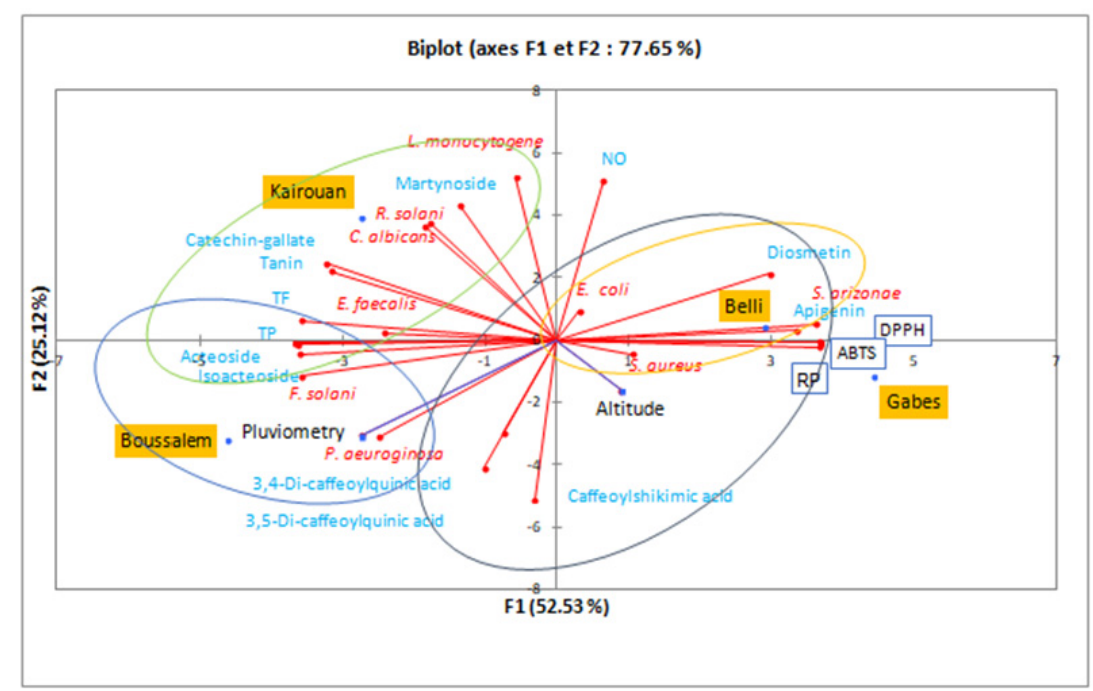
Figure 6. Principal component analysis in a biplot of the lemon verbena populations according to the composition of methanolic extracts, their activities and climatic conditions. TP: total polyphenols, TF: total flavonoids, NO: anti ‐ inflammatory, DPPH, ABTS: antifree radical activity, RP: reducing power.